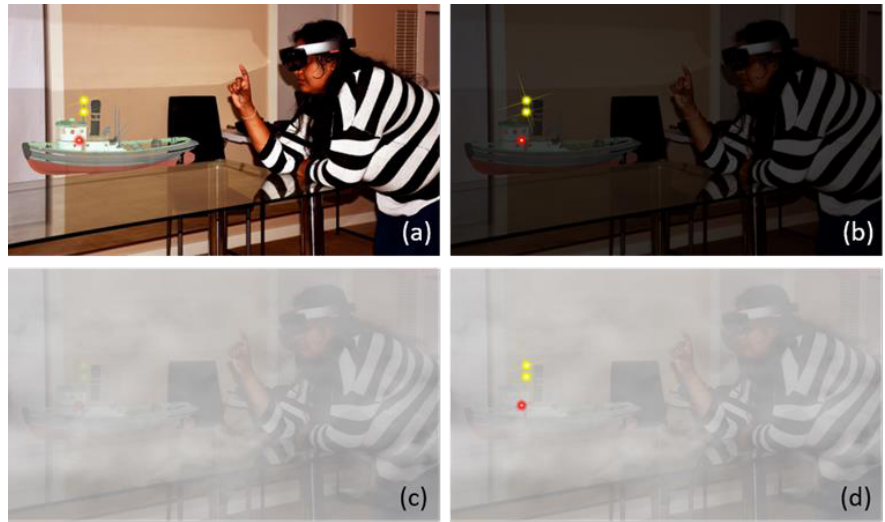
Figure 1. The user sees the real world as well as the virtual world (Augmented Reality (AR) vessel with navigation lights) in ( a ) normal condition; ( b ) night condition with lights visible; ( c ) fog condition where lights are not visible; ( d ) fog condition with holographic lights (giving a demonstration / visualization of